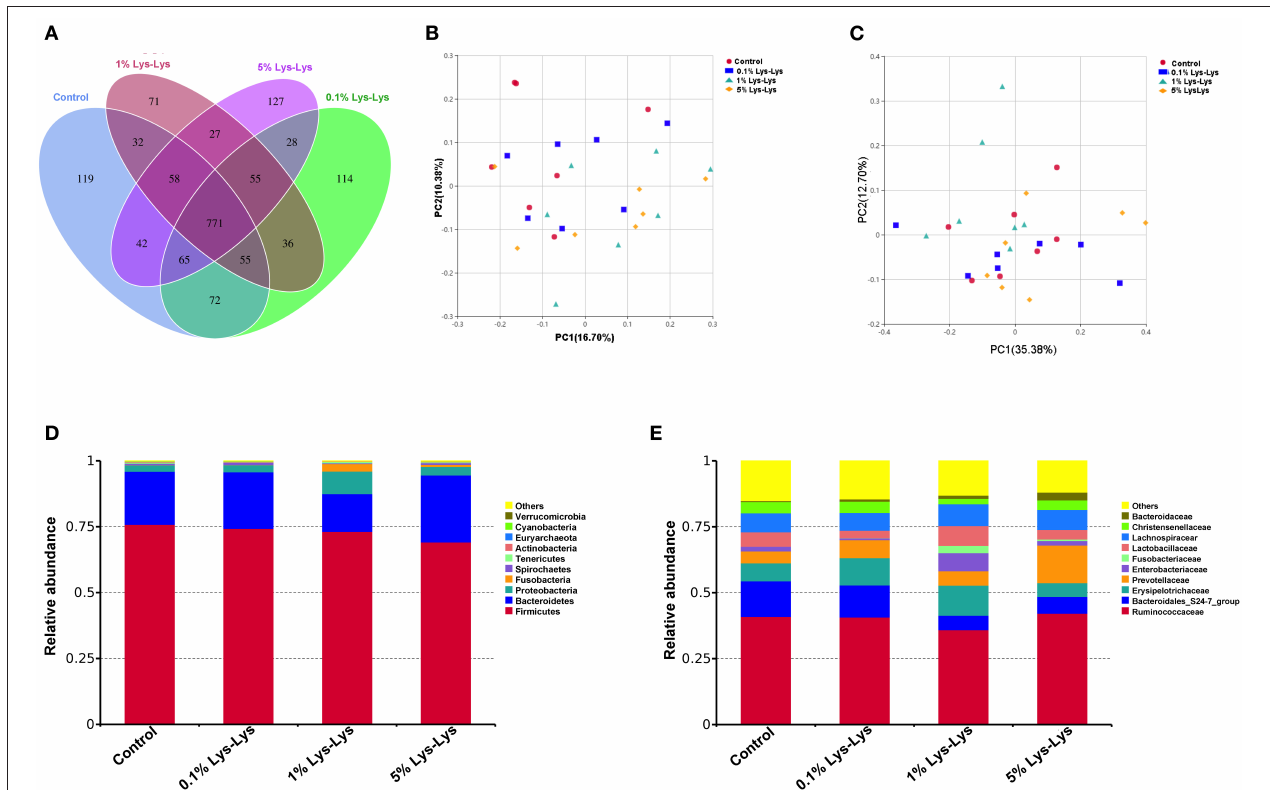
FIGURE 5 | Effect of the Lys-Lys dipeptide on intestinal microbiota in piglets. (A) Venn diagram illustrating the overlap of operational taxonomic units (OTUs) in the intestinal microbiota of piglets. (B) Principal coordinate analysis (PCoA) of unweighted UniFrac distance. (C) PCoA of weighted UniFrac distance. (D) Relative abundance of the top 10 phyla in each sample. (E) Relative abundance of the top 10 families in each sample. Data were expressed as the mean ± SEM ( n = 7). *Different from control, P < 0.05.